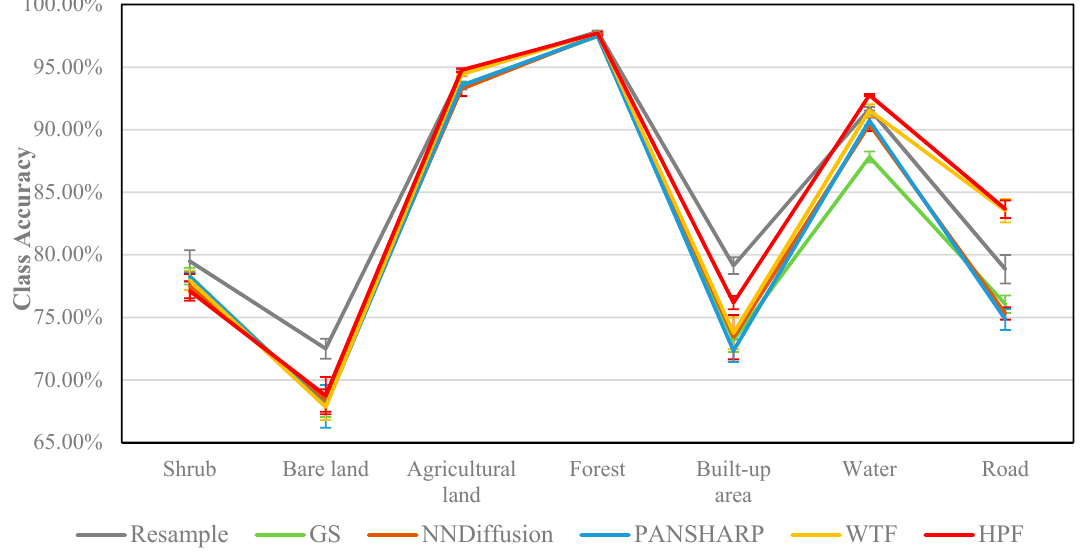
Figure 5. Feature importance of ten spectral bands using data sets obtained by six downscaling methods.